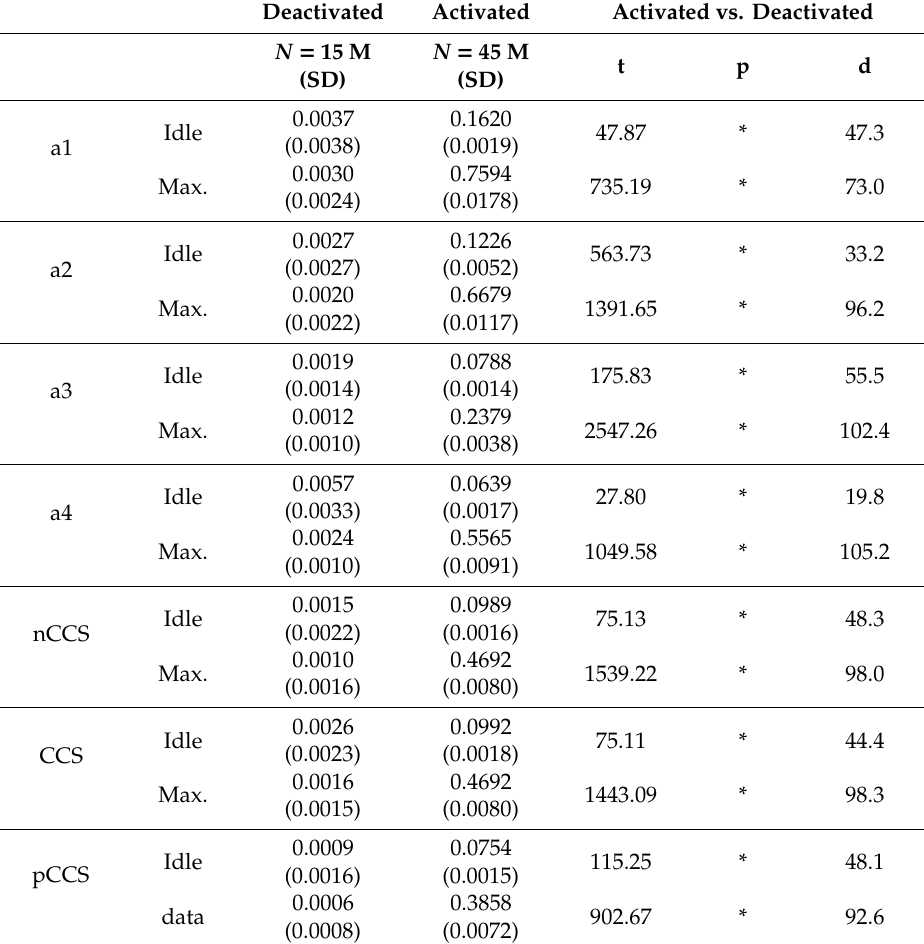
Table 5. Sample description and statistical comparison of the peak amplitudes of the straw walkers in the individual spectra (a1–4) and the non-coherent (nCCS), coherent (CCS), and poly-coherent (pCCS) composite spectra, under two working conditions (deactivated, activated) and (at idle and at max. RPM)